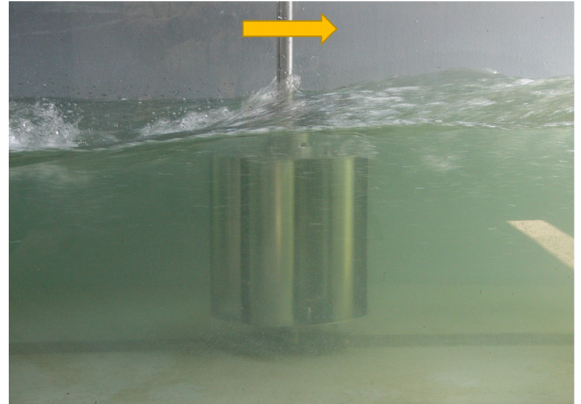
Figure 7. Rotation of the 6-bladed turbine in the